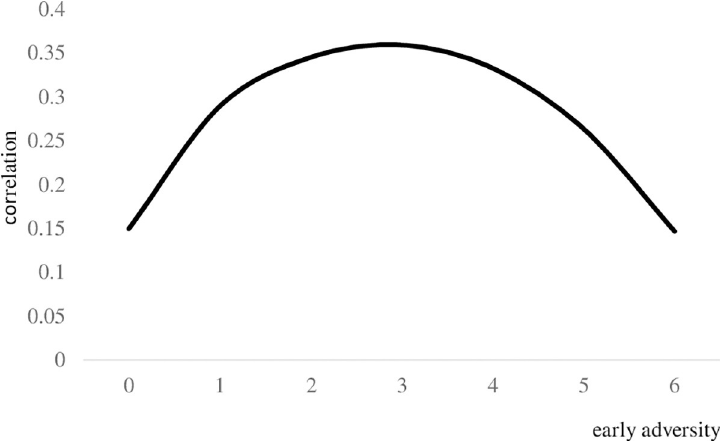
Fig 6. The correlations between ongoing chronic stressors and neuroticism on the basis of early adversity in the HRS sample. Ongoing chronic stressors included measures of chronic work, family, and financial difficulties.